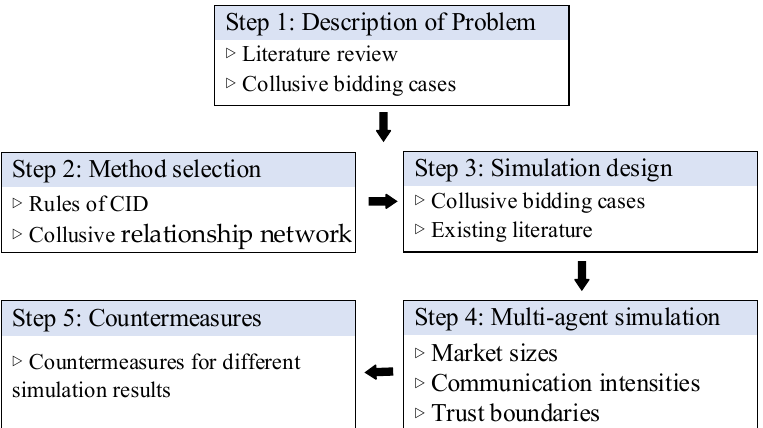
Figure 1. The framework of the methodology.